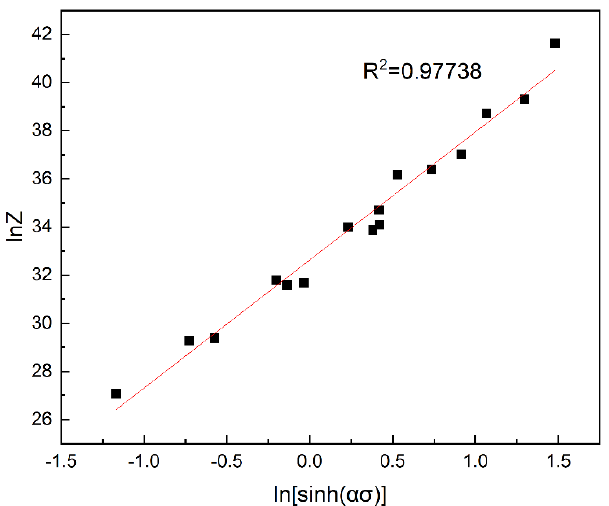
Figure 3. Linear fitting under true strain of 0.5: ( a ) ln 𝜀̇ −σ; ( b ) ln 𝜀̇ −lnσ; ( c ) ln 𝜀̇ − ln[sin h( ασ )]; ( d ) ln[sin h( ασ )] − 1000/T.